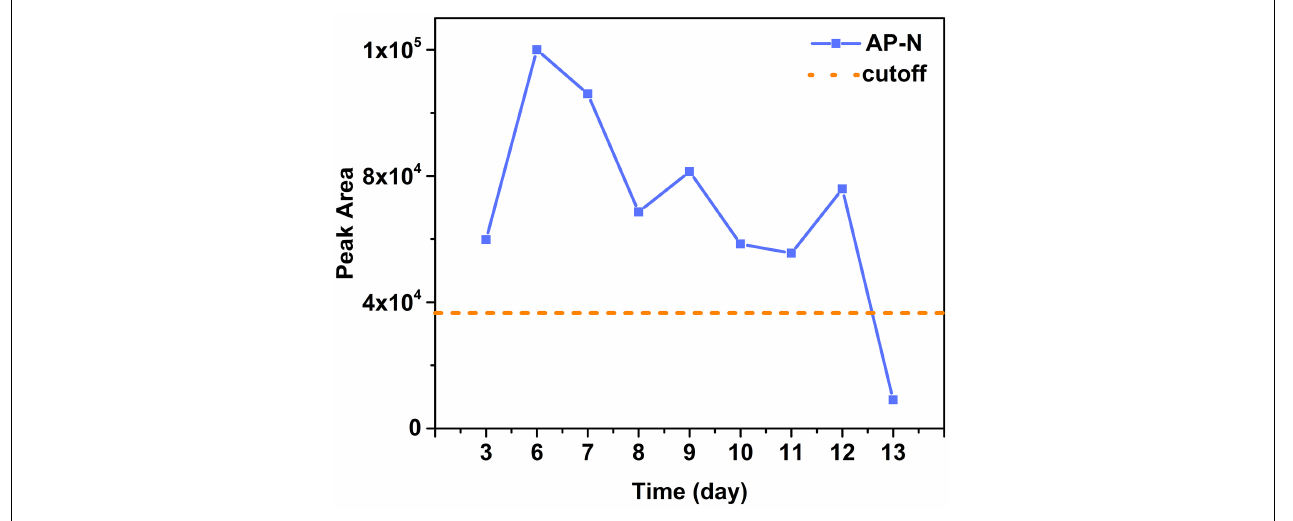
FIGURE 3 | The peak areas of AP-N in sera of Patient 2 on different days and the cutoff value (three times of the blank). Results showed sera of Patient 2 were positive for BoNT/A on day 3 to day 12 with a maximum on day 6 and then gradually decreased.